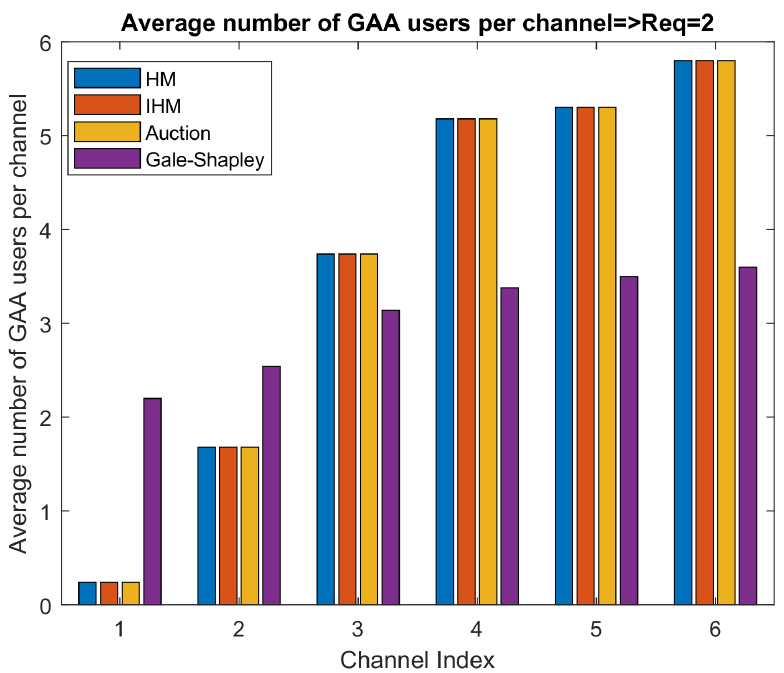
Figure 6. Average number of users when channels required: